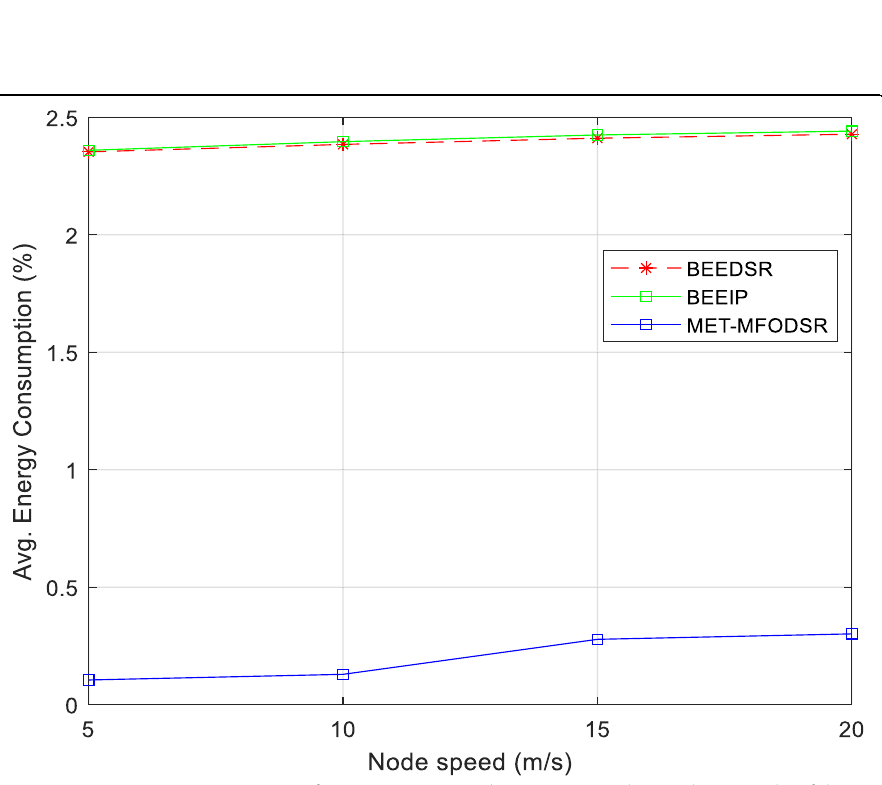
Fig. 13 Average energy consumption for BEEDSR, BeeIP, and MET-MFODSR. The simulation results of the average energy consumption under the node speed